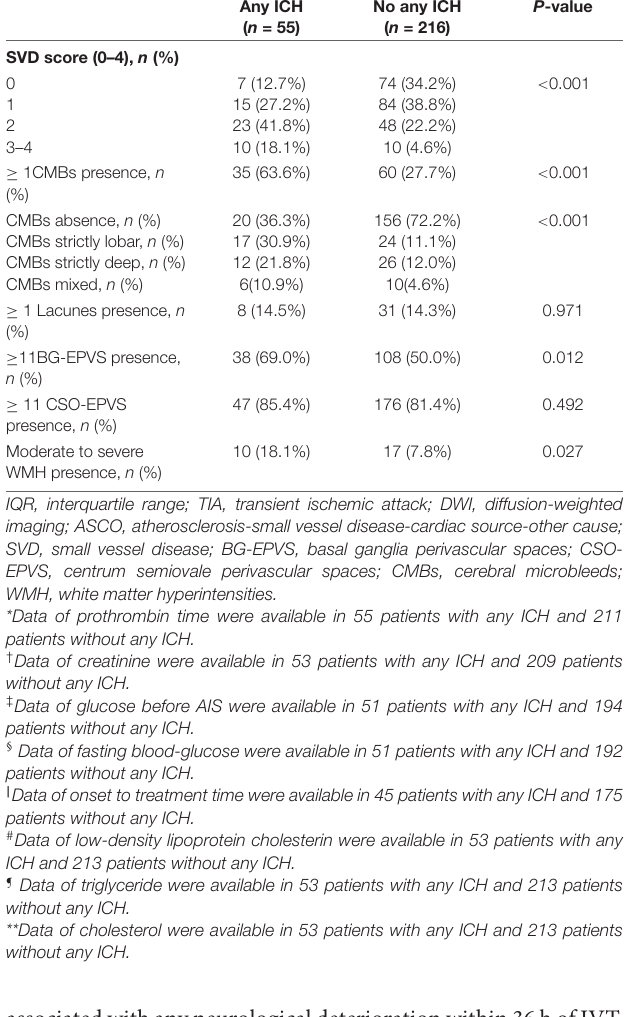
TABLE 1 | Baseline clinical and radiological characteristics for patients with and without any ICH after